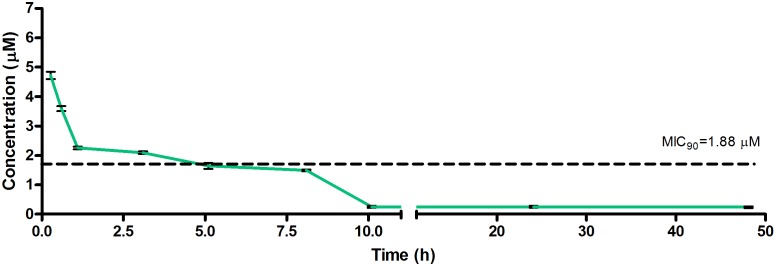
Total concentrations for RMB073 following intravenous administration in an uninfected murine model.